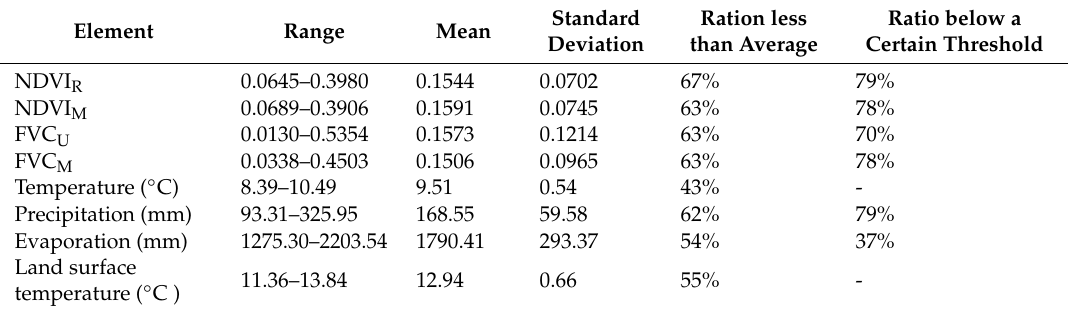
Table 1. Descriptive statistics of each